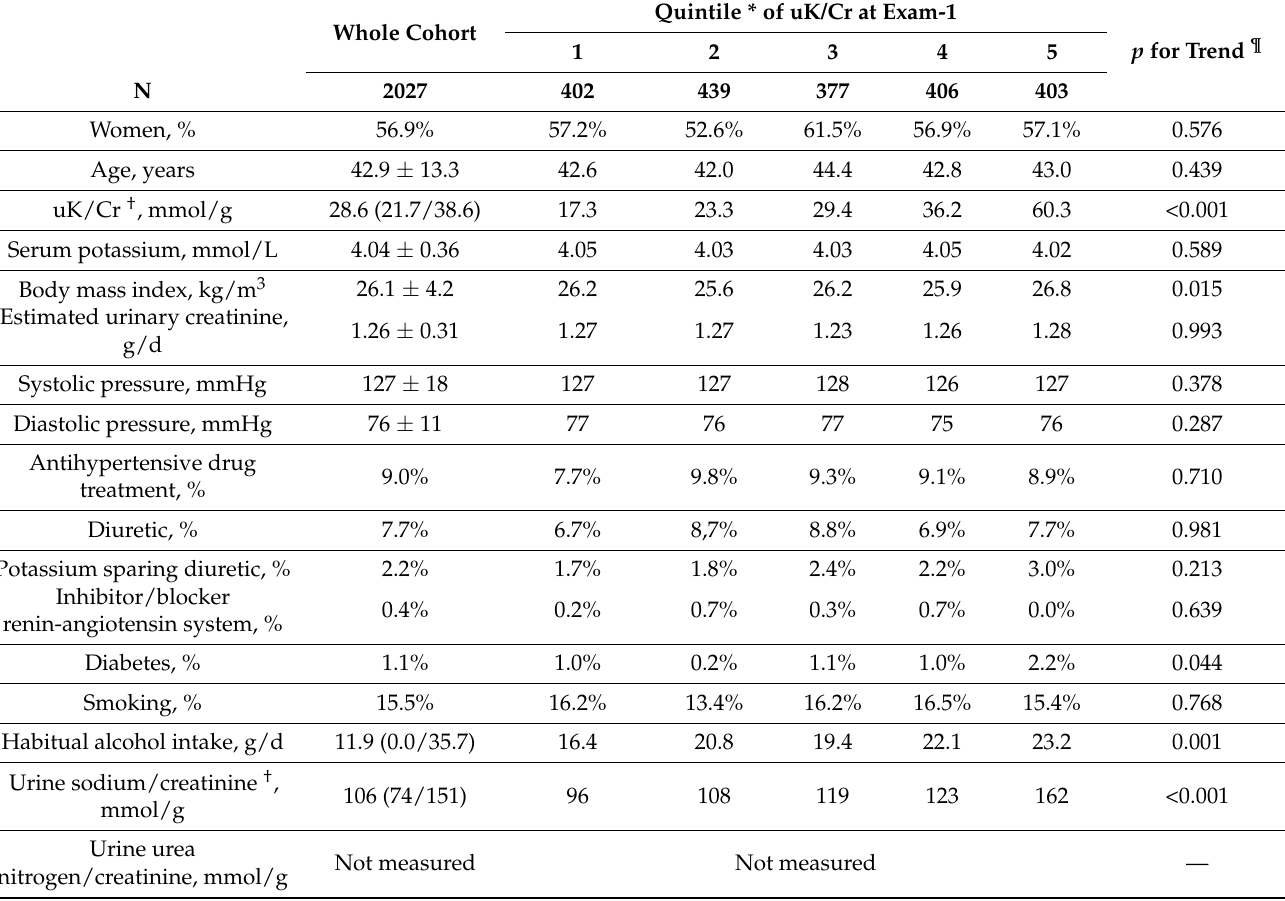
Table 1. Descriptive statistics for data of exam-1 in whole cohort (prevalence for categorical variables, mean ± SD for non-skewed numerical variables, and median with interquartile range for skewed variables) and trend analyses by quintiles of uK/Cr (prevalence or